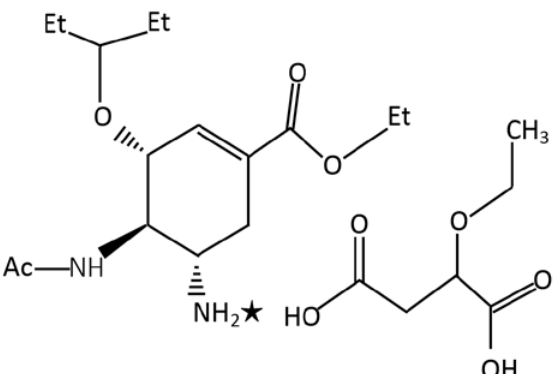
Figure 1. Ethyl (3S,4R,5S)-4-acetamido-5-amino-3-(1-ethylpropoxy)cyclohex-1-en-1-carboxylate ethoxy succinate formula . ✭ -hydrogen